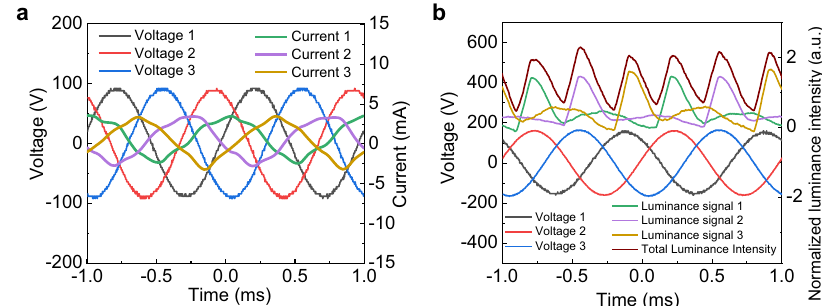
Fig. 7 Phase characteristics of green TP-OLED. a Oscilloscope signals of the three-phase voltage at V rms = 71 V, 1 kHz and corresponding three-phase current oscillograms. b Relationship between the periods of three-phase driving voltage ( V rms = 106 V, 1 kHz) and the light output for each phase. Source data are provided as a Source Data